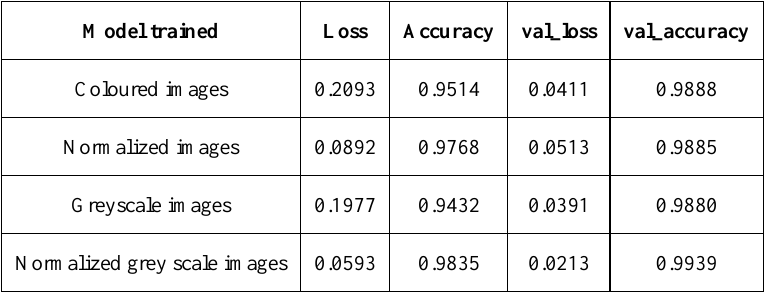
Table 2. Training validation accuracy and